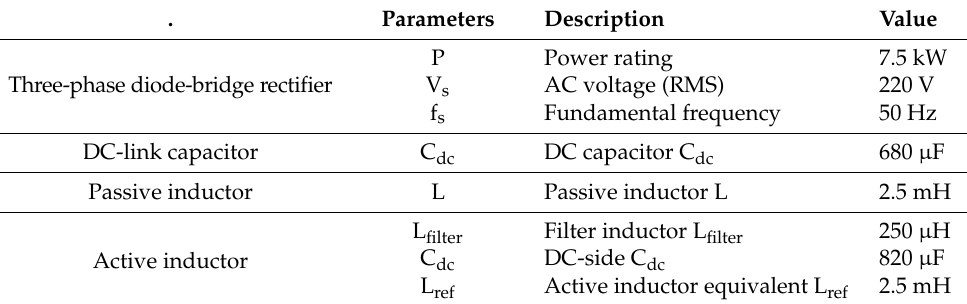
Figure 1. System structure of the adjustable speed drive (ASD) system with the DC-link LC filter. L dc is the DC-link magnetic inductor, which would be replaced by the variable active inductor. Table 1. Specification of an ASD system for performance